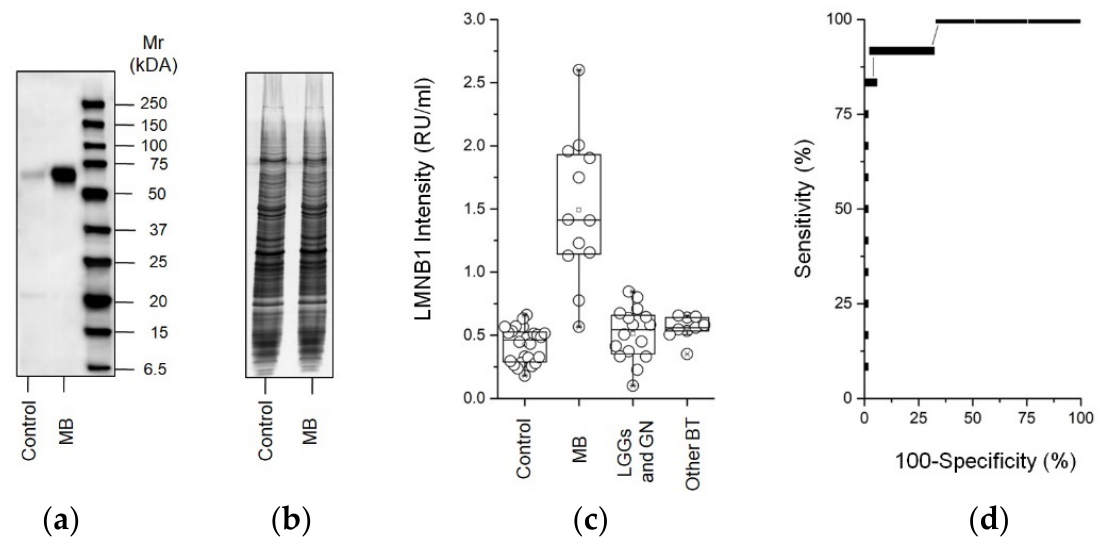
Figure 5. LMNB1 evaluation of the total fraction of CSF from the EVD of MB or control patients. ( a ) Representative western blot analysis and ( b ) gel stained with Blue Silver according to Candiano G. et al. [33] (used as a loading control) of full length gel (12–16T%) for LMNB1 in the total fraction of CSF from the EVD of control and Medulloblastoma (MB); ( c ) Box plot showing the median